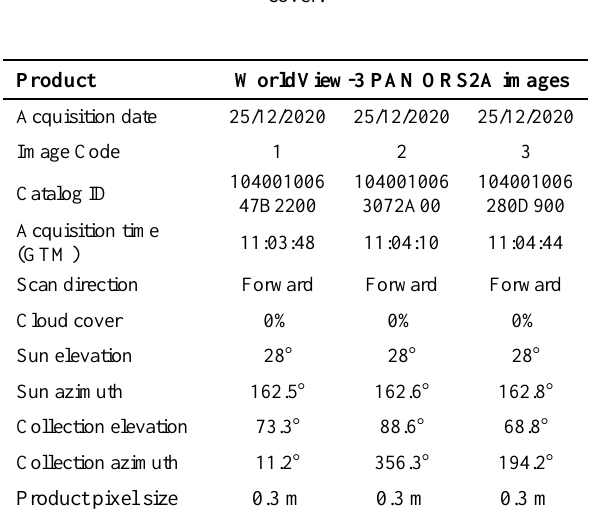
Figure 2 . Study area over a PAN WV3 orthoimage and the three selected subareas of 250 by 250 m on urban (blue square), bare soil (red square) and plastic greenhouse (green square) land cover.